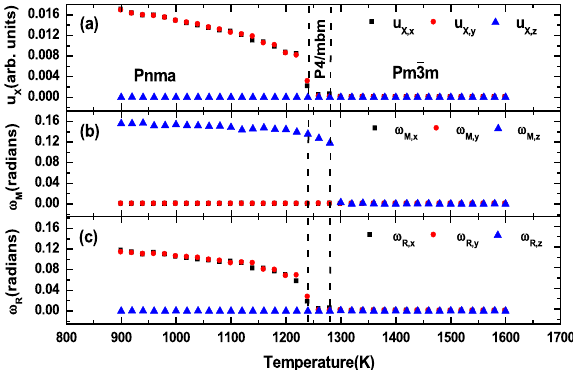
Fig. 1 Predicted temperature dependence of the antipolar u X vector a , in-phase tilting ω M pseudo vector b and antiphase tilting ω R pseudo-vector c in our BFO system subject to hydrostatic pressure. The dashed vertical lines delimit three different structural phases (see